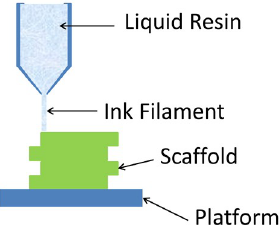
Figure 7. Schematic of extrusion based printing. A liquid resin is extruded in the form of a filament into a predetermined pattern.